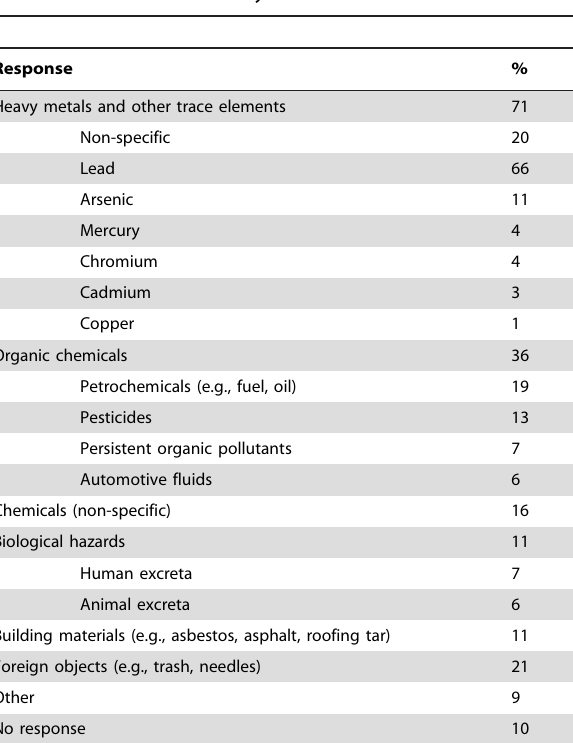
Table 1. Open-ended responses to questions about soil contaminant knowledge: ‘‘What soil contaminants are you aware of that urban gardeners should be concerned about in general?’’ and ‘‘As a community gardener, do you have any concerns about hazards to your health?’’